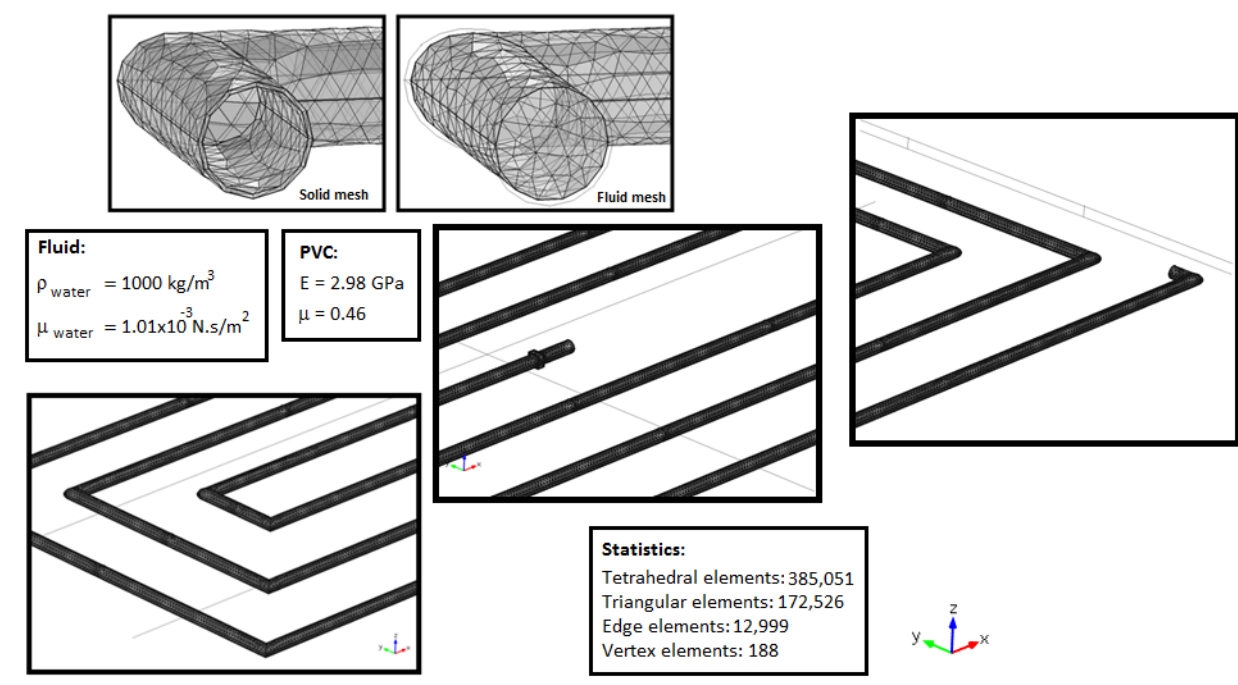
Figure 8. Fluid and structure integrated mesh.